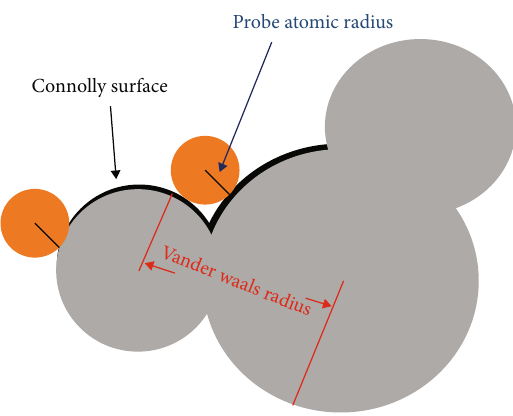
Figure 7: Schematic diagram of Connolly